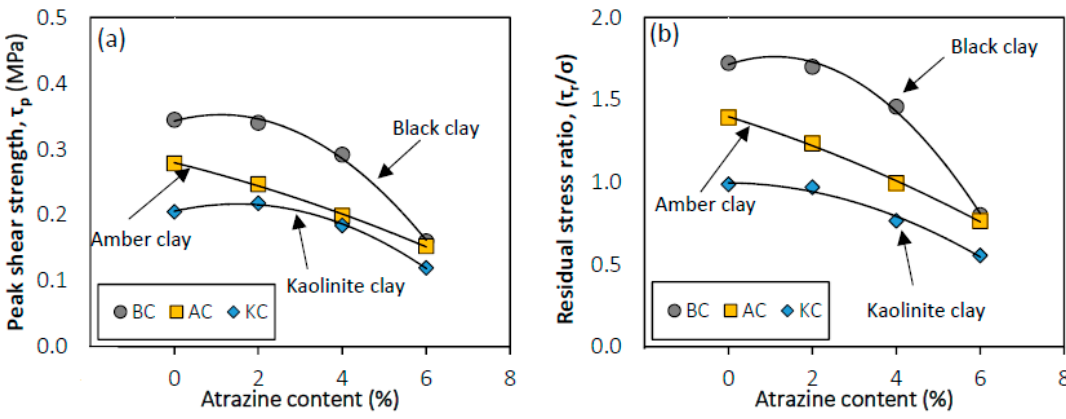
Figure 8. Ring shear test results for AC, BC and KC specimens under 200 kPa normal stress for ( a ) peak shear stress versus atrazine content; ( b ) Residual stress ratio versus atrazine content.